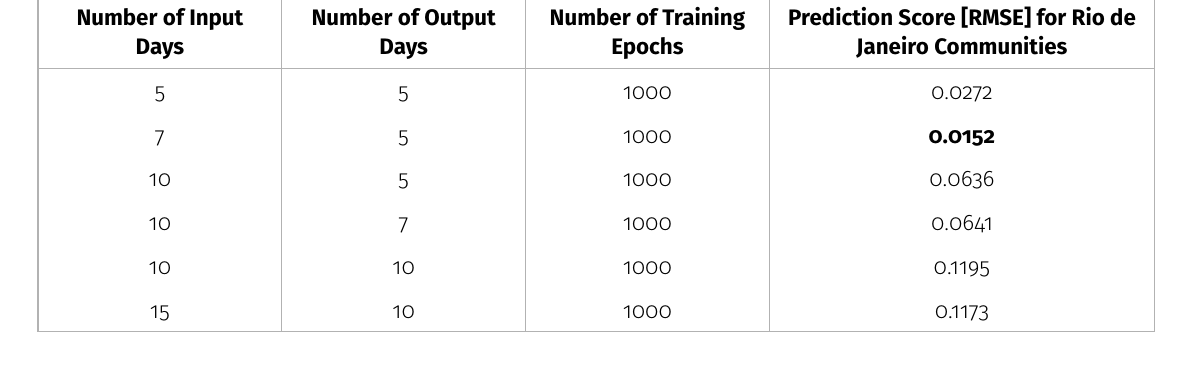
Table IV. LSTM Models Results for Rio de Janeiro Favelas.